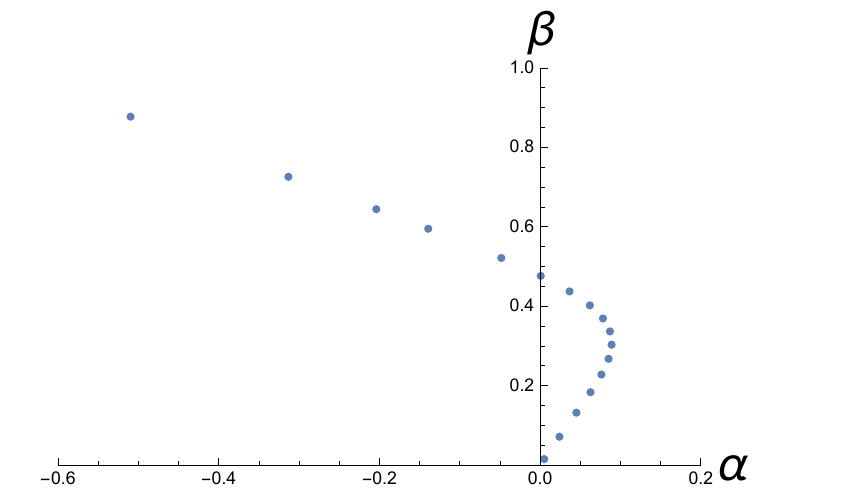
√ 3 , Q A = 1 , C = 0 by varying Q B . We vary Q B in such